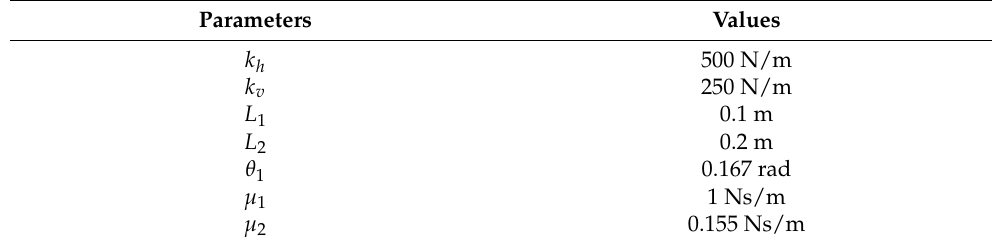
Table 3. Parameters of the X-shaped structure.